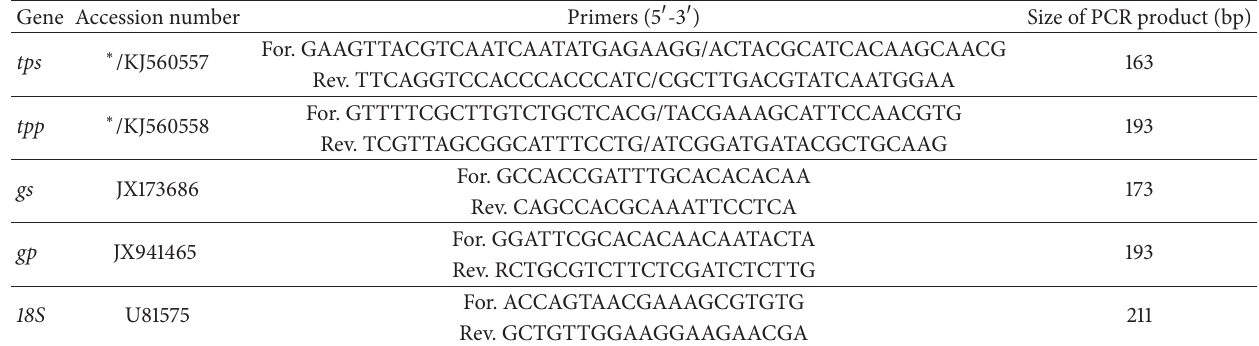
Table 2: Primer sequences used for semiquantitative and real-time